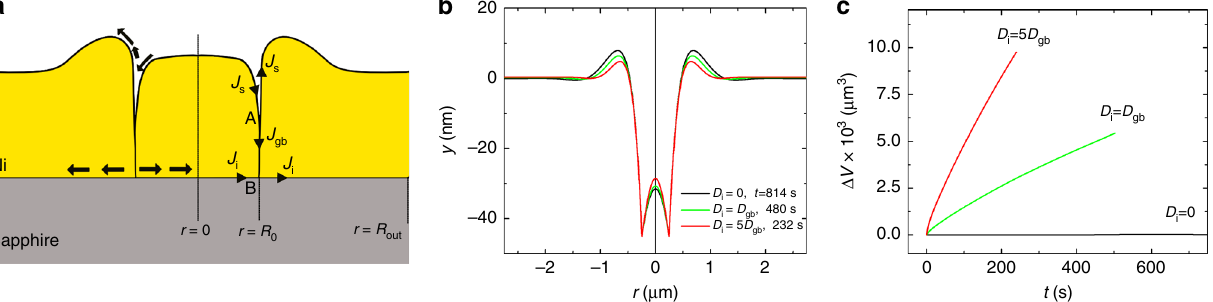
Fig. 2 Development and results of the morphology evolution model. a The Ni/sapphire model showing Ni fl ux along the Ni surface ( J s ), along the GB (A is the GB root position) between the sinking middle grain and the outer grain ( J gb ), and along the Ni/sapphire interface ( J i ) (B is the location of the intersection of the GB and the interface). b Surface topography pro fi les y ( r ) for three different interface diffusivities shown in black, green and red at the time t when the GB root hits the metal/ceramic interface at 700 °C. c Calculated “ missing ” Ni volume Δ V vs. time